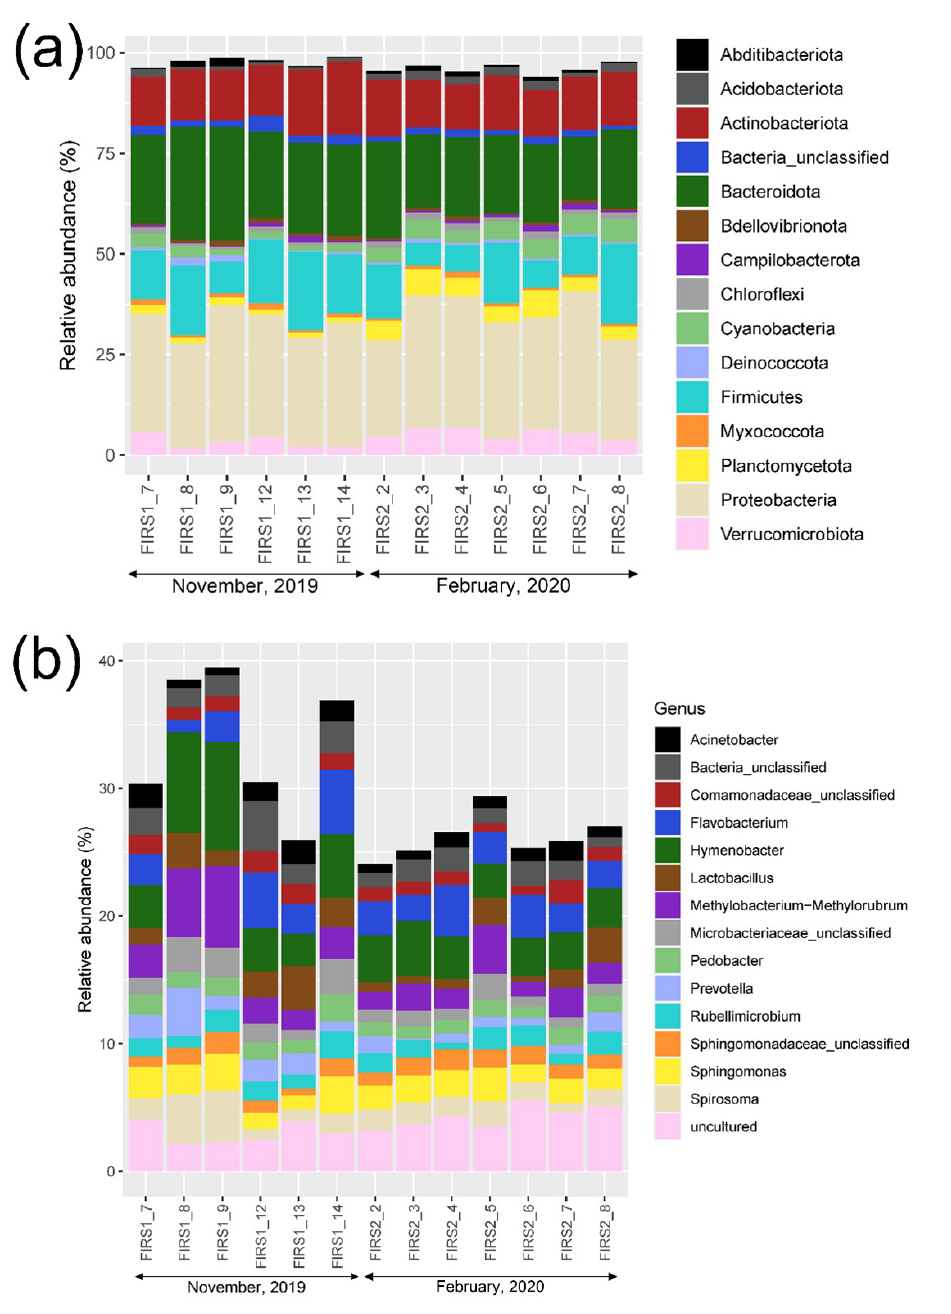
Figure 4. The 15 most abundant prokaryotic phyla ( a ) and genera ( b ) in the